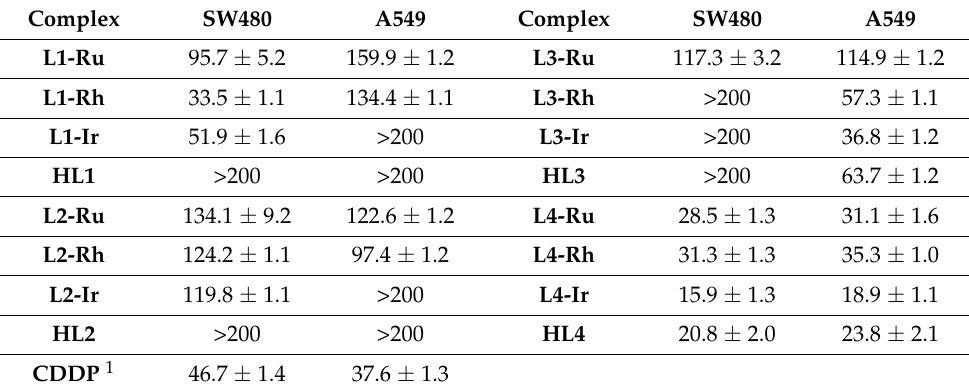
Table 1. IC 50 values expressed in µ M after an exposition period of 24 h for all the synthesized complexes and their ligands in colon (SW480) and lung (A549) cancer cell